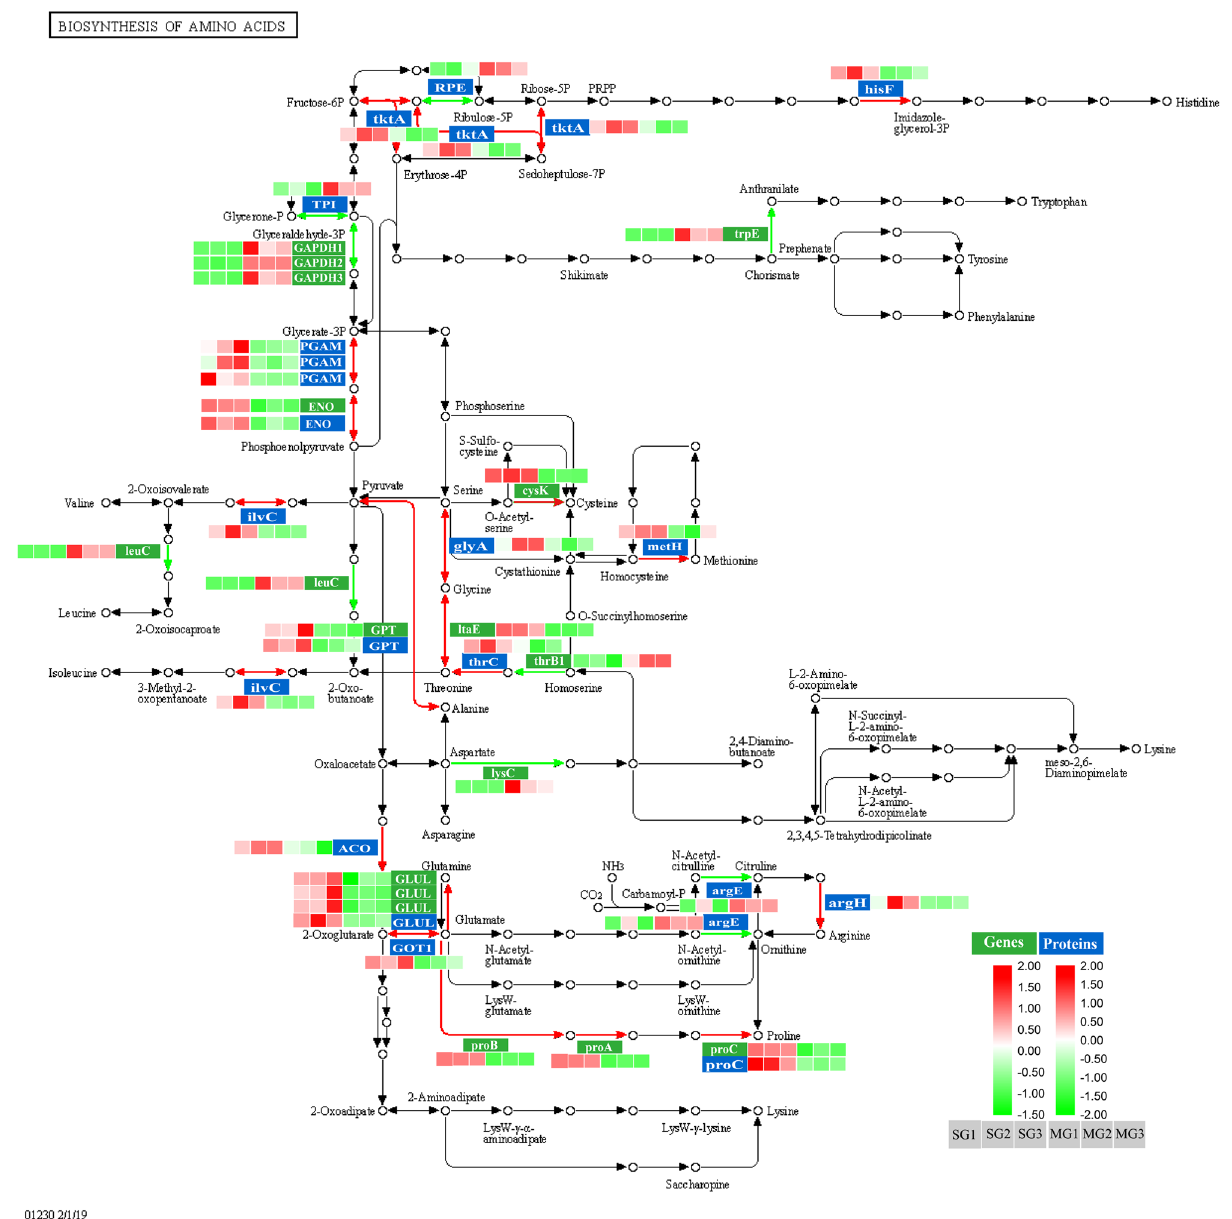
Figure 6. Abundance patterns of transcripts and protein species involved in the biosynthesis of amino acids of NIL-723 and NIL-1010. White characters with a green background represent genes, whereas white characters with a blue background represent protein species. For each gene or protein, the blocks represent expression levels in replications 1, 2, 3 of SG and MG from left to right. The expression value was log 2 transformed. Red represents up-regulated and green represents down-regulated. The KEGG pathway was obtained from the Kanehisa Laboratory (www. kegg. jp/ kegg/ kegg1.